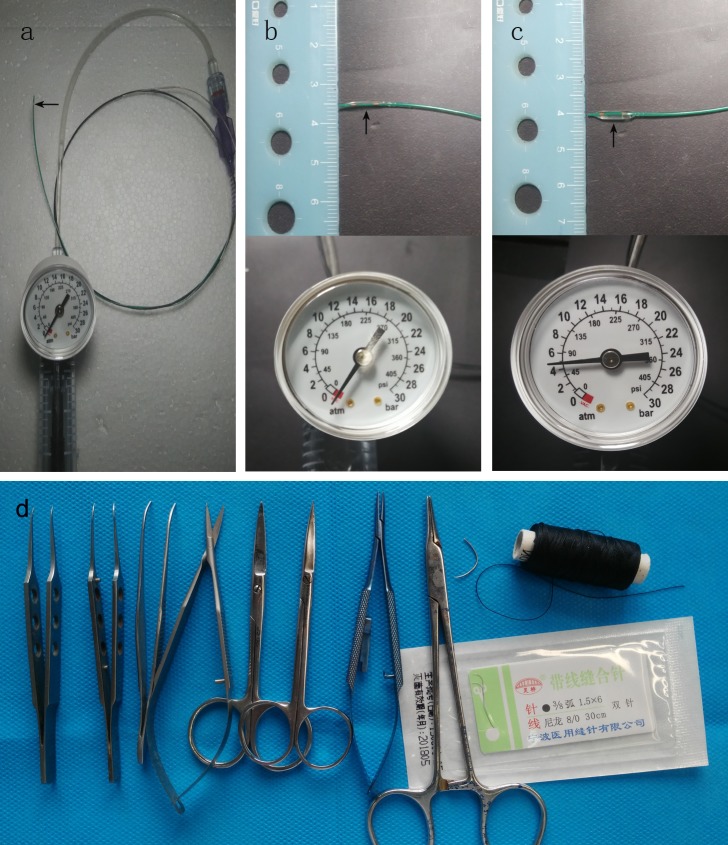
Photographs of the balloon and pressure pump.a. Balloon connected with the pressure pump. b. When the pressure pump was at negative pressure, the balloon was deflated. c. When the pressure pump was at 4–6 atm, the balloon was inflated. Arrows in photographs show the balloon. d. Instruments from the left to the right: smooth tying forceps, toothed tying forceps, curved toothed forceps, Vannas scissors, straight ophthalmic scissors, curved ophthalmic scissors, microneedle holder, needle holder, suture needle,4–0 Non-absorbable surgical suture, surgical suture needles with thread.